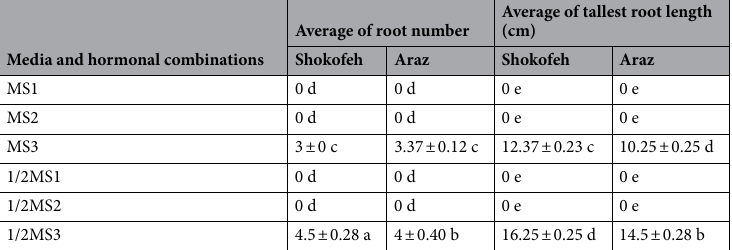
Average of root number